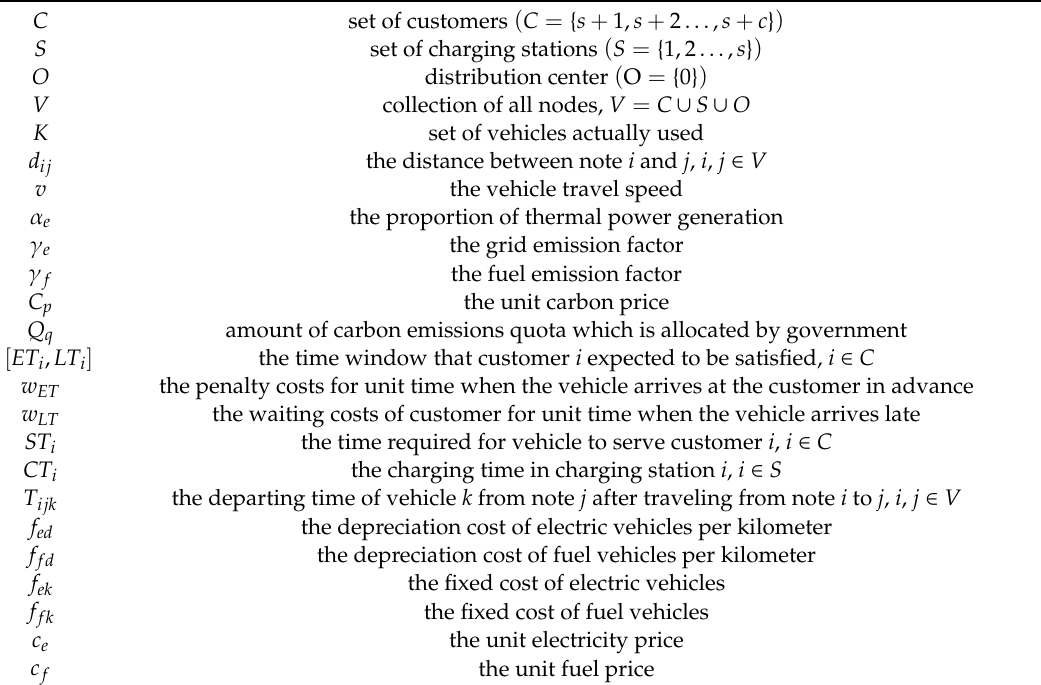
Table 1. Description of symbols.